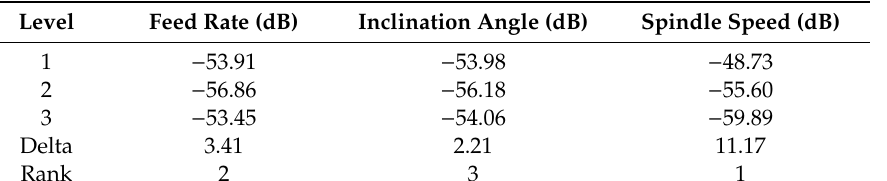
Table 10. Response table for mean S / N ratios for cutting power.